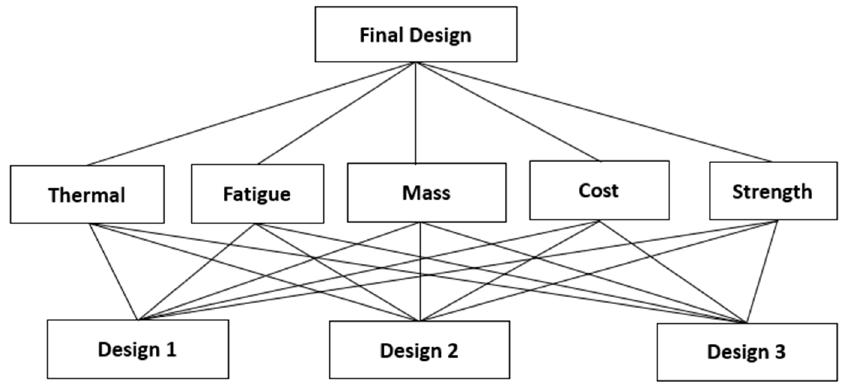
Figure 5. Multi-design optimization analysis, as adapted from [46].